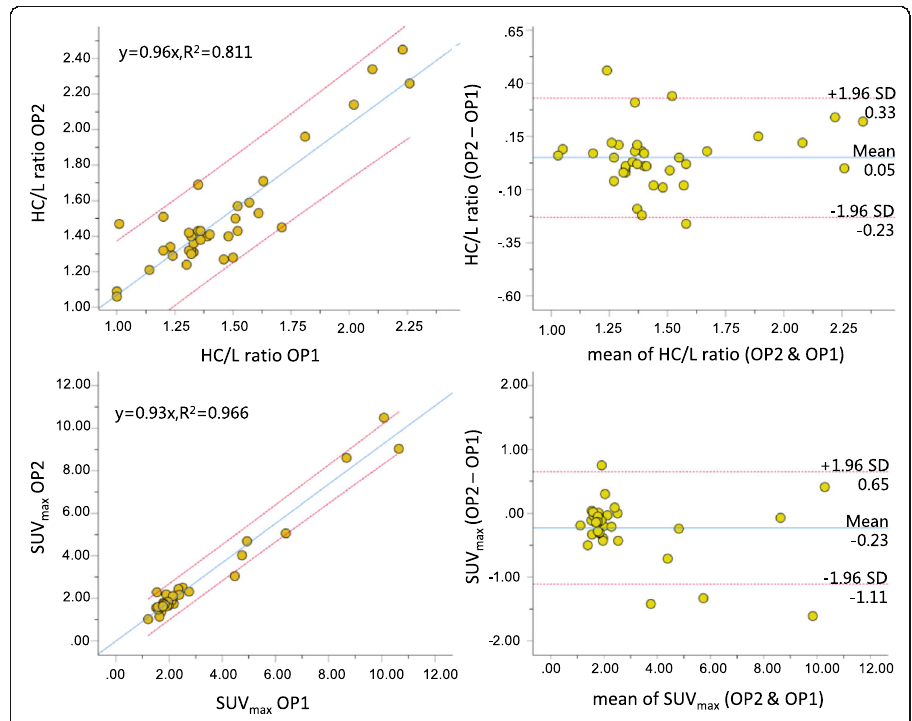
Fig. 6 Linear regression and Bland-Altman plots of H/CL ratio and SUV max measured by OP1 and OP2 who processed the same image sets